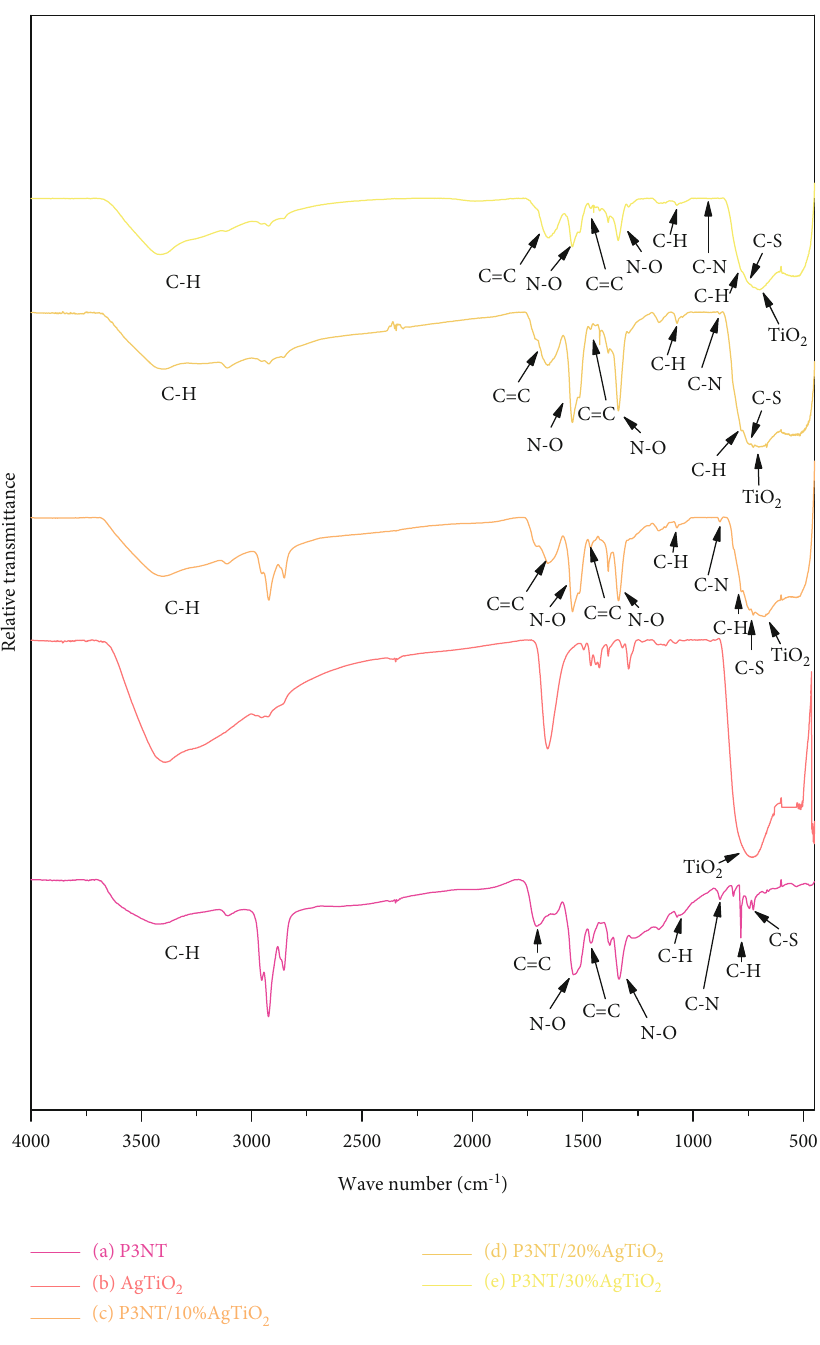
Figure 1: FTIR of P3NT (a), AgTiO 30%AgTiO NCs 2